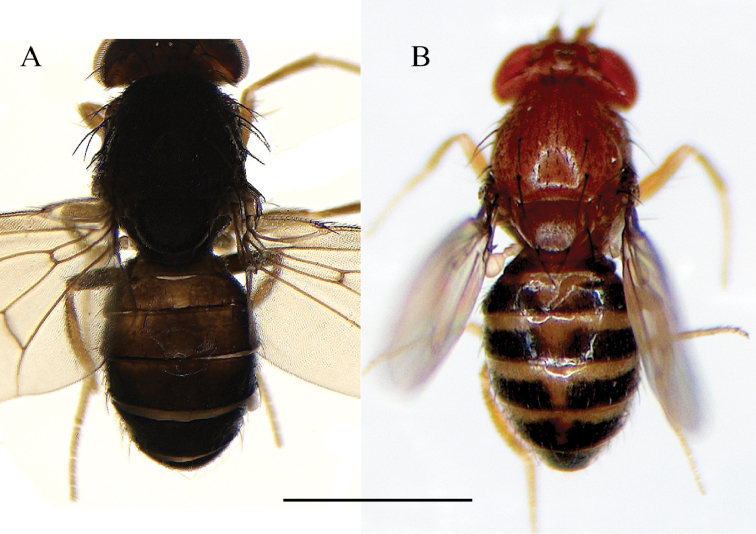
ADrosophilacaxarumi sp. n., male holotype external morphology, dorsal view. BDrosophilaguaraja King, from Zamora Chinchipe, Ecuador, male external morphology, dorsal view. Scale bar: 1 mm.